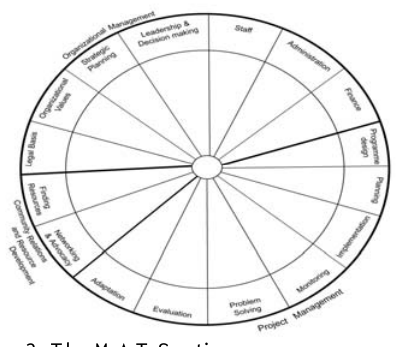
Figure 3: The MAT Sections Source: INTRAC, Organizational Assessment of Southern NGOs, Brighton UK, 14- 18 October